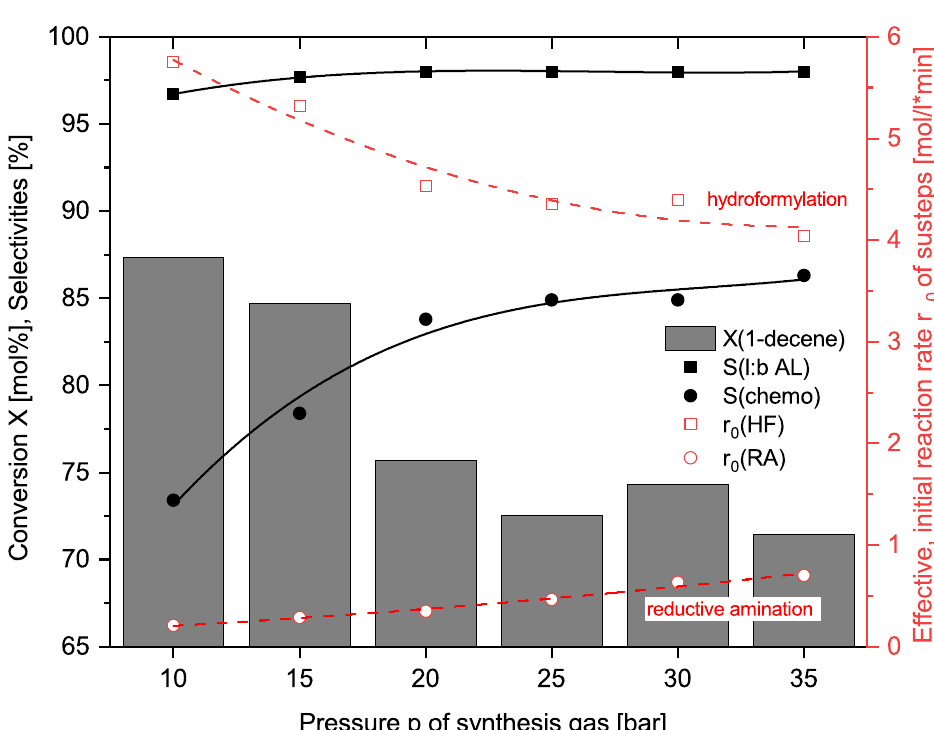
Figure 4. Influence of synthesis gas pressure on the conversion and yield of the hydroaminomethyla- tion of 1-decene and the effect on the effective reaction rates of the partial steps hydroformylation and reductive amination. Reaction conditions: T=120 ◦ C, p=xbar H 2 /CO (2:1), 0.23mol% Rh, 0.92mol% SX, 0.66 mol/L 1-decene and DEA, 9g dodecane (co-solvent), 12g water, 8wt% Marlophen NP8, 1wt% Na 2 SO 4 , 1200rpm,